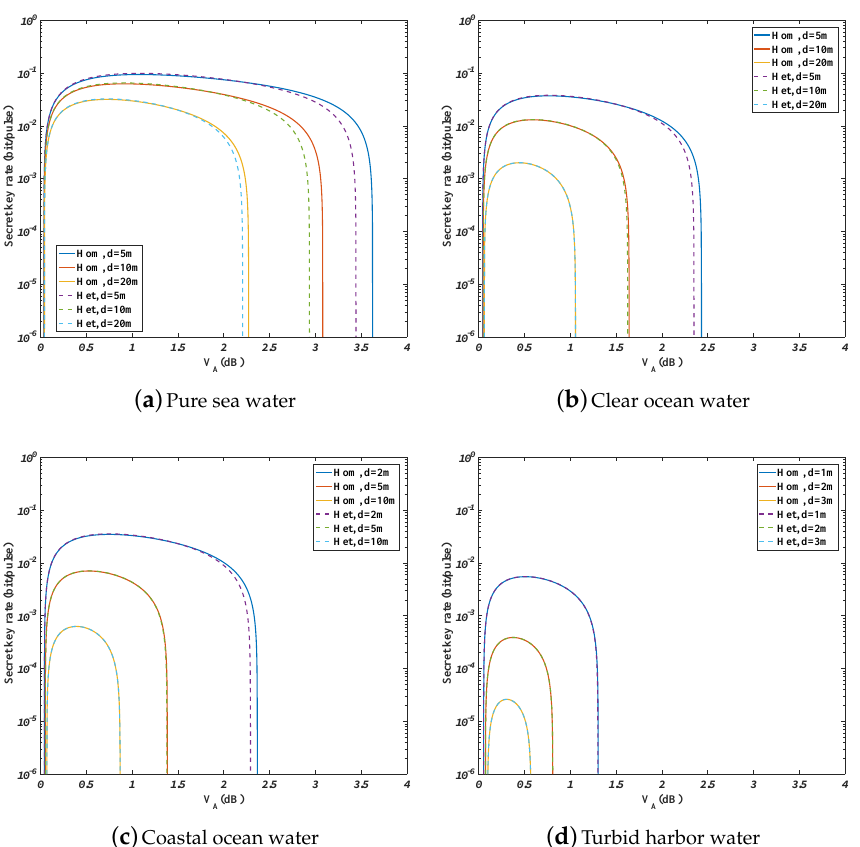
Figure 10. (Color online.) The compressed variation trend of V A optimal interval of the eight-state protocol as the transmission distance extends. β = 0.9, ε = 0.005, η = 0.6, v el =